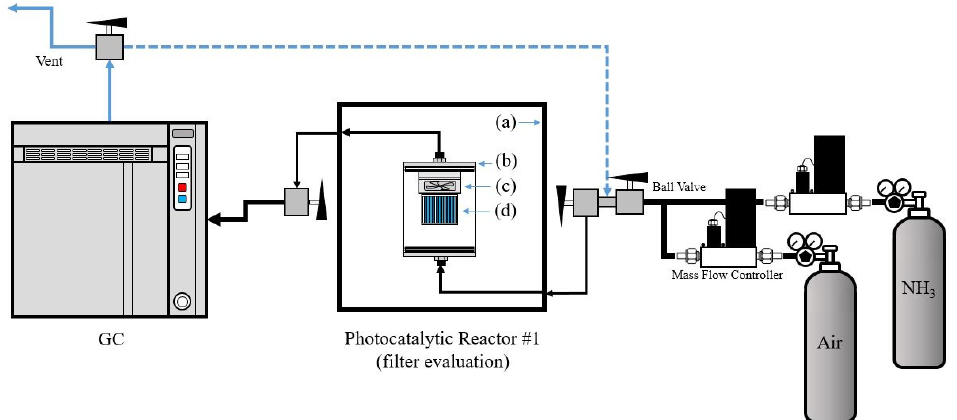
Figure 2. Schematic image of reactor #1 for the evaluation of the photocatalytic filter-type module performance: ( a ) dark box, ( b ) cylindrical test chamber, ( c ) DC fan and DC power supply, and ( d ) photocatalytic filter-type module.